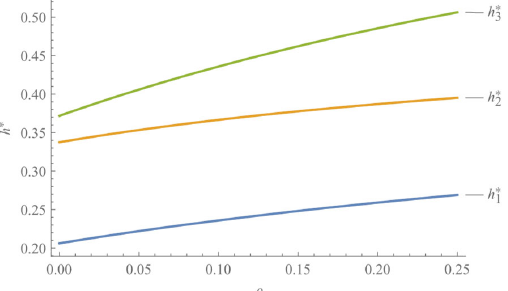
Fig. 5. The impact of the manufacturer's risk aversion on Fig. 6. The impact of manufacturer’s risk aversion on the